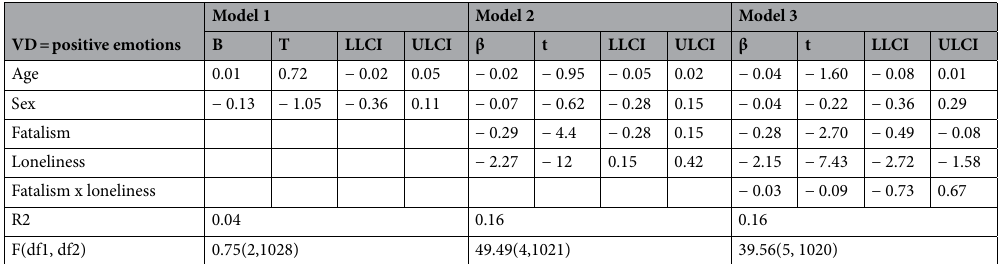
Table 7. Linear regression and Hayes’ linear regression analyses considering loneliness as a moderator (Dependent variable: positive